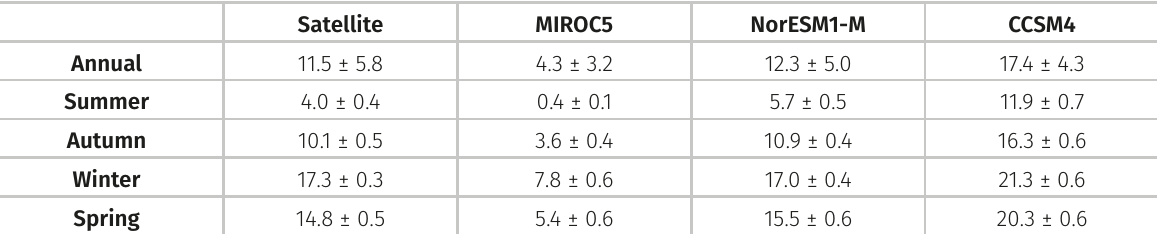
Table I. Annual and seasonal mean (1979-2005), with respective standard deviations, of the Antarctic SIE derived from satellite data and simulated in the 3 CMIP5 models (MIROC5, NorESM1-M and